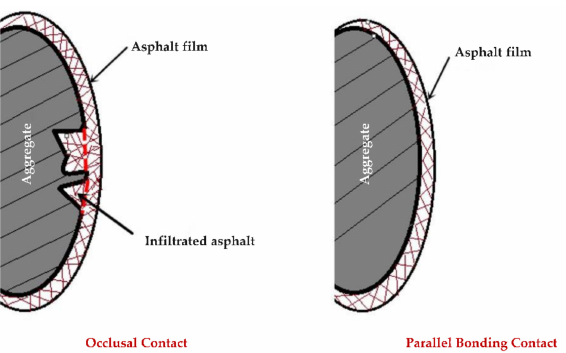
Figure 11. Schematic diagram of occlusal contact and parallel bonding contact.